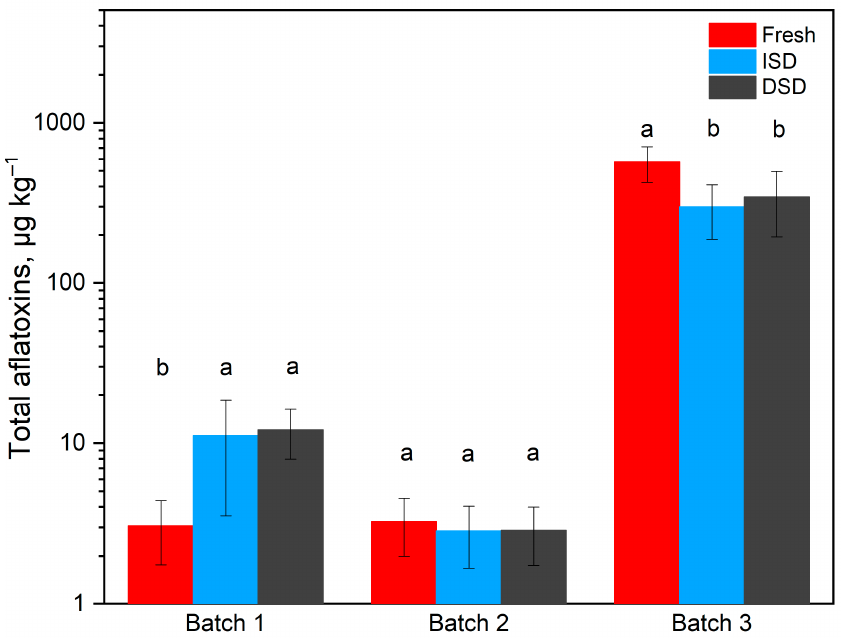
Figure 5. Total aflatoxin content in fresh maize, maize dried in the inflatable solar dryer (ISD), and maize dried under direct sun (DSD) for the three batches (Treatments with same letters are not significantly different, p ≤ 0.05).